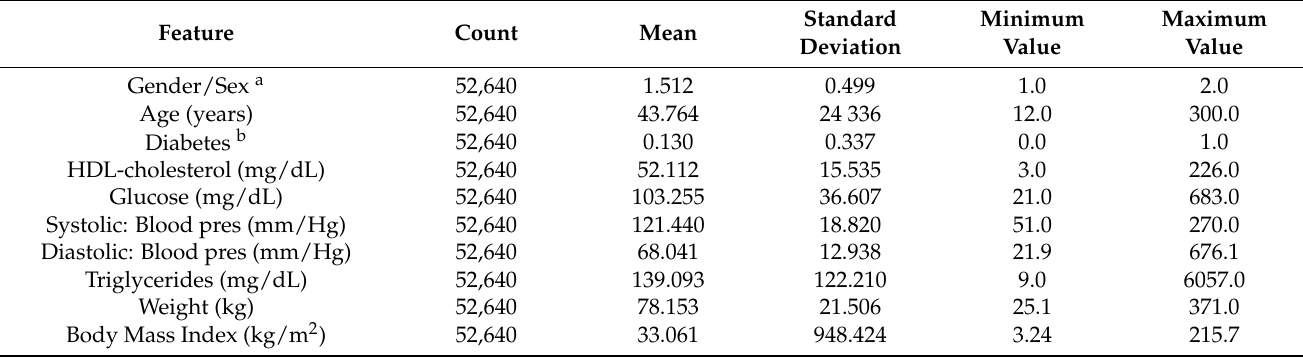
Table 1. Data statistics before the preprocessing.